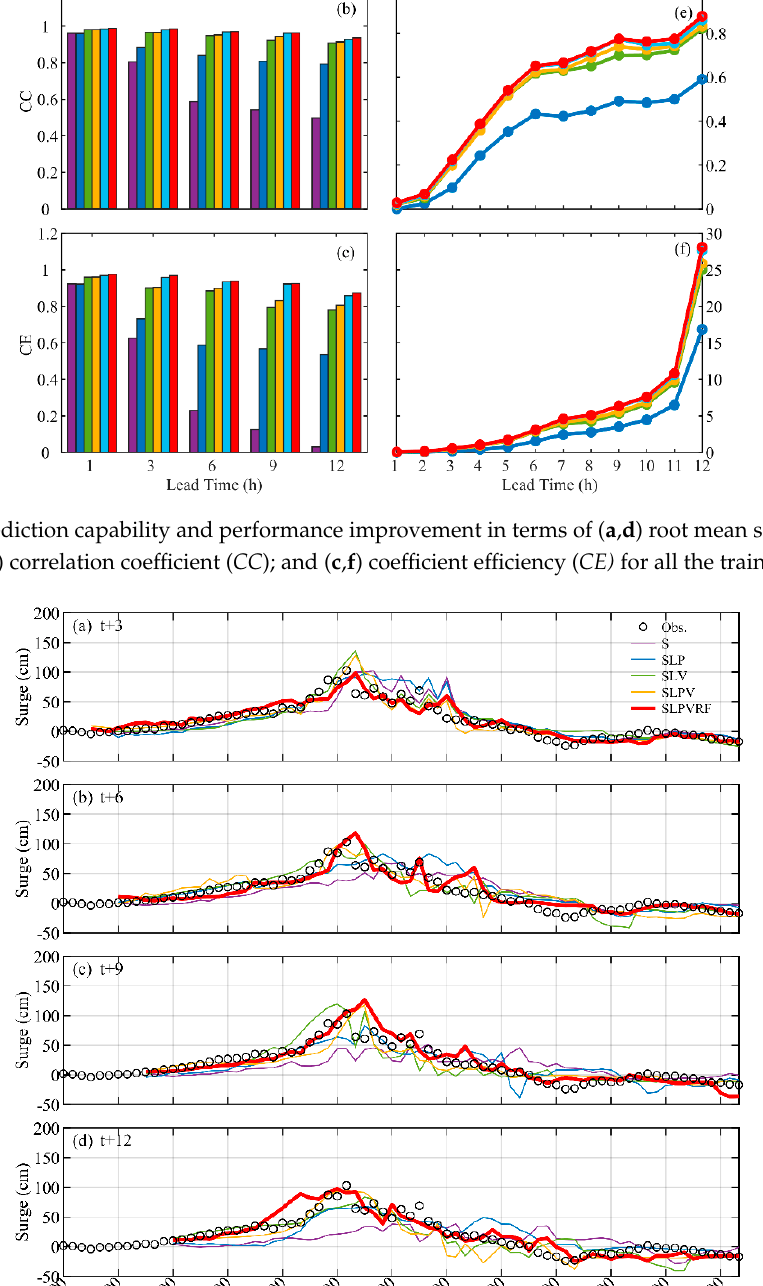
Figure 11. Scatter plots of predicted and measured storm surges for all validation events under different input combinations (from top to bottom panels) and lead-time (various symbols): ( a ) S , ( b ) SLP, ( c ) SLV, ( d ) SLPV, and ( e ) SLPVRF.